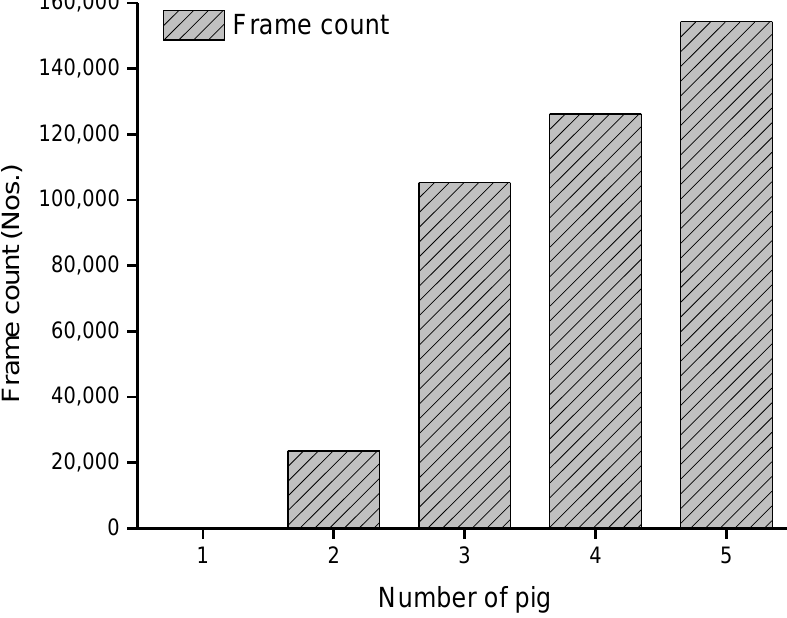
Figure 13. Number of frames vs. number of visible pigs during the study period. Even though there was no spatial variation in the GHGs in the livestock barn [47], we took three air samples from three spatial locations near the center of the pig barn each time and averaged them, as shown in Figure 1. The acquisition of GHG values using the air sampling method collects the air samples near the center of the barn. Dong et al. [47] collected air samples from three pen sections near the middle area of each pen. The space of two pens had an equal size of 4 m × 7 m each, and the third one had 8 m × 8 m. Likewise, Ni et al. [48] chose the one-one location for each pen near the exhaust fan (1 m from central exhaust fan) and one at the center of the aisle in the large pig barn of size 61.0 m × 13.2 m. Compared to those pig barns, our pig barn was small in size (5.4 m × 3.4 m), and we have collected three gas samples from three different locations and averaged them so that the GHG values would be more reliable. Dong et al. [47] reported that the GHG concentration profile in the pig barn has diurnal variations. A similar pattern was observed in our pig barn, with the concentration being higher in the nighttime and lower in the daytime. All the GHG concentrations displayed almost a similar pattern. The GHG concentrations in the morning were high because of the reduced ventilation at low temperatures during the nighttime, resulting in highly concentrated GHGs. CO 2 gas was found in